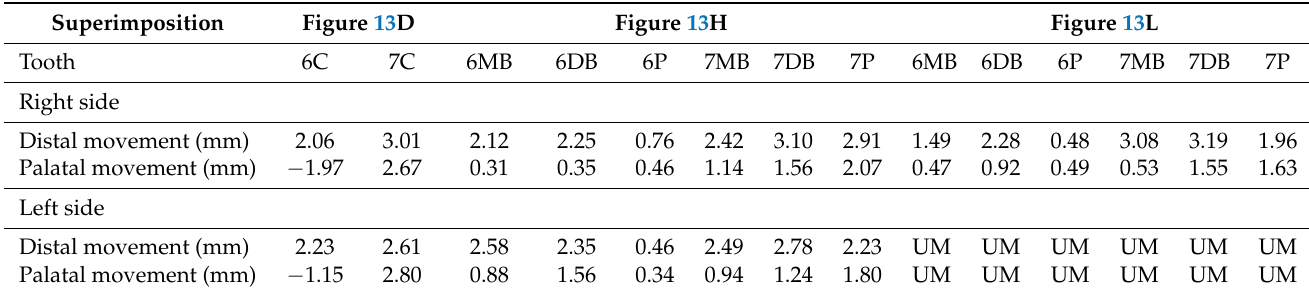
Table 2. Distal and palatal movement of the maxillary first and second molars measured with superimposed CBCT